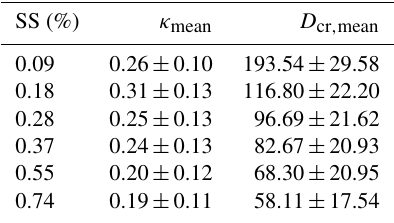
Table 2. Average κ and D cr values at WFJ for each SS measured between 24 February and 8 March 2019. Uncertainty for each value is expressed by the standard